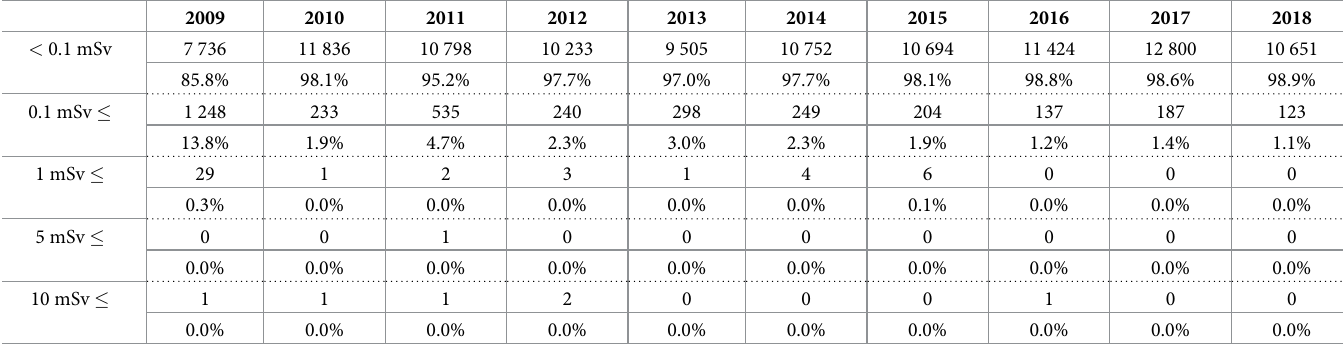
Table 2. Number and percentage of participants classified by a range of annual effective internal doses